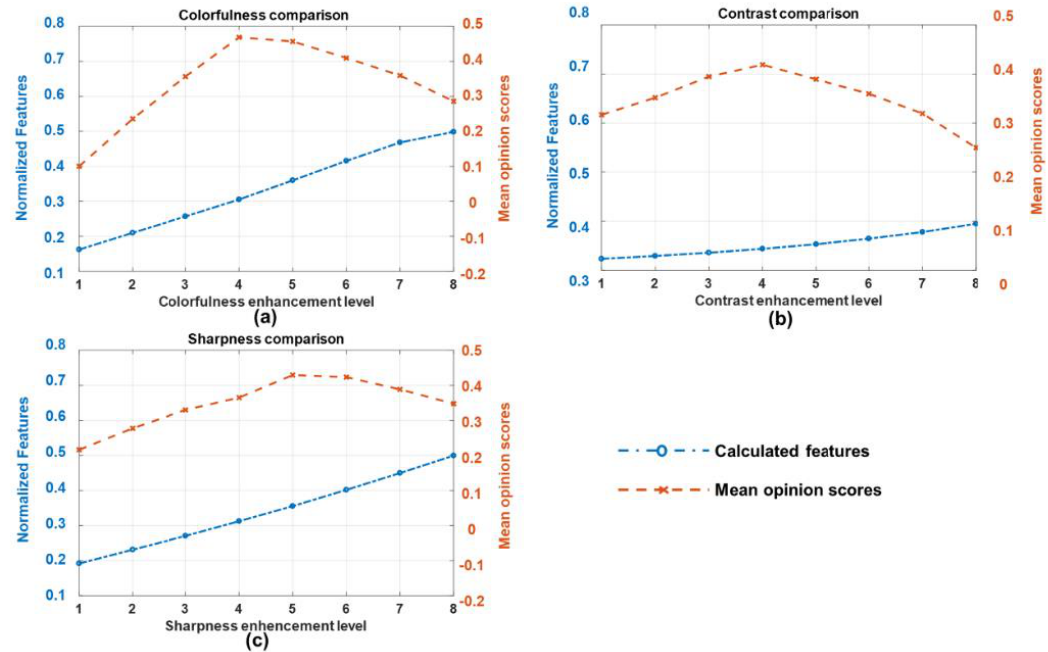
Figure 1. Subjective evaluation scores (x-) and calculated feature values (o-) for different adjustment levels on ( a ) colorfulness adjustment, ( b ) contrast adjustment, and ( c ) sharpness adjustment. While the calculated feature values keep increasing as the level of adjustment increases, the subjective scores increase only until the level of adjustment of about four or five levels and then they decrease thereafter until the eighth adjustment level.